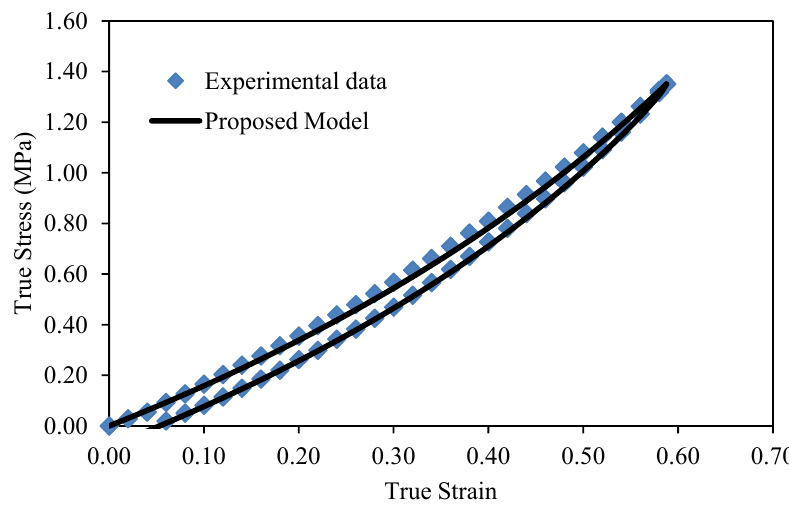
Figure 9. Comparison of experimental data with respect to stress-softened predictions obtained from Equation (25) for 1 phr of CB-reinforced elastomer.